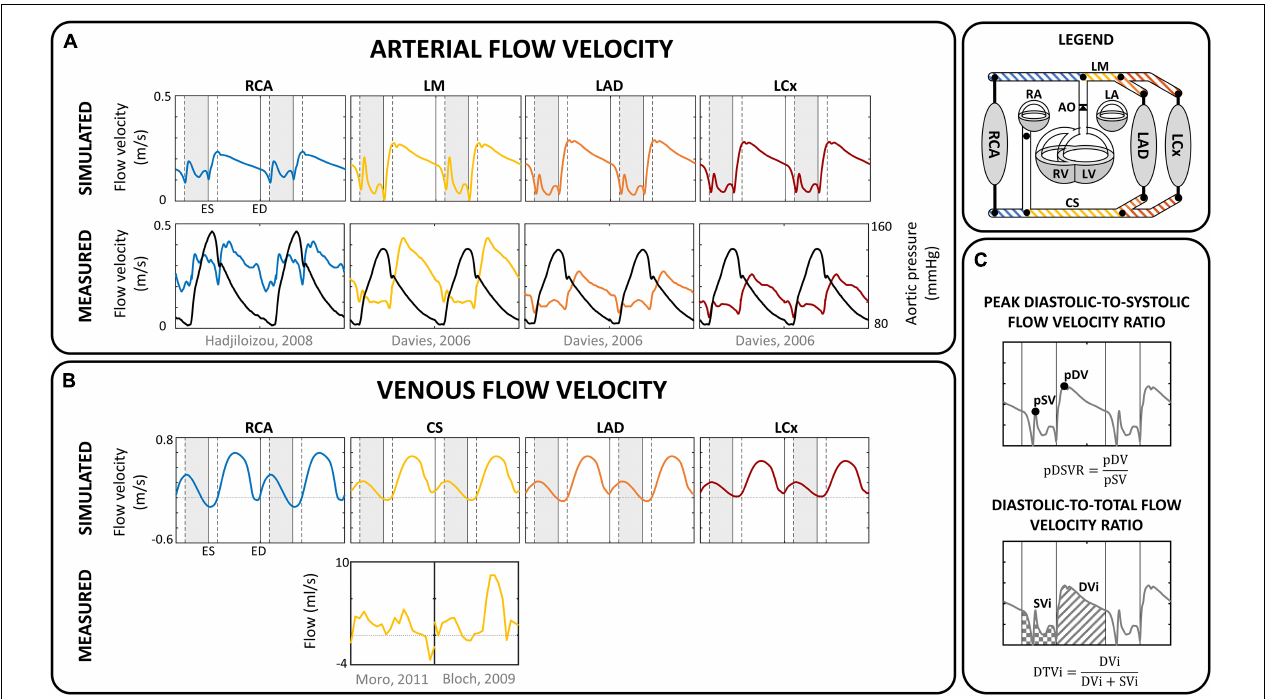
FIGURE 3 | Flow velocity. Comparison of simulated (A) arterial and (B) venous flow velocity with measured flow (velocity) in corresponding sites for a single human subject (Davies et al., 2006; Hadjiloizou et al., 2008; Bloch et al., 2009; Moro et al., 2011). Vertical gray areas indicate left ventricular ejection and vertical dashed/solid lines indicate opening/closing of left ventricular cardiac valves. (C) Analysis of coronary flow waveform, in terms of peak diastolic-to-systolic flow velocity ratio (pDSVR) and diastolic-to-total flow velocity time integral (DTVi) as reported in Table 3 . CS, distal coronary sinus; DVi, diastolic velocity integral; ED, end-diastole; ES, end-systole; LA, left atrium; LAD, left anterior descending coronary; LCx, left circumflex coronary; LM, left main coronary; LV, left ventricle; pDV, peak diastolic velocity; pSV, peak systolic velocity; RA, right atrium; RCA, right coronary artery; RV, right ventricle; S, septum; SVi, systolic velocity